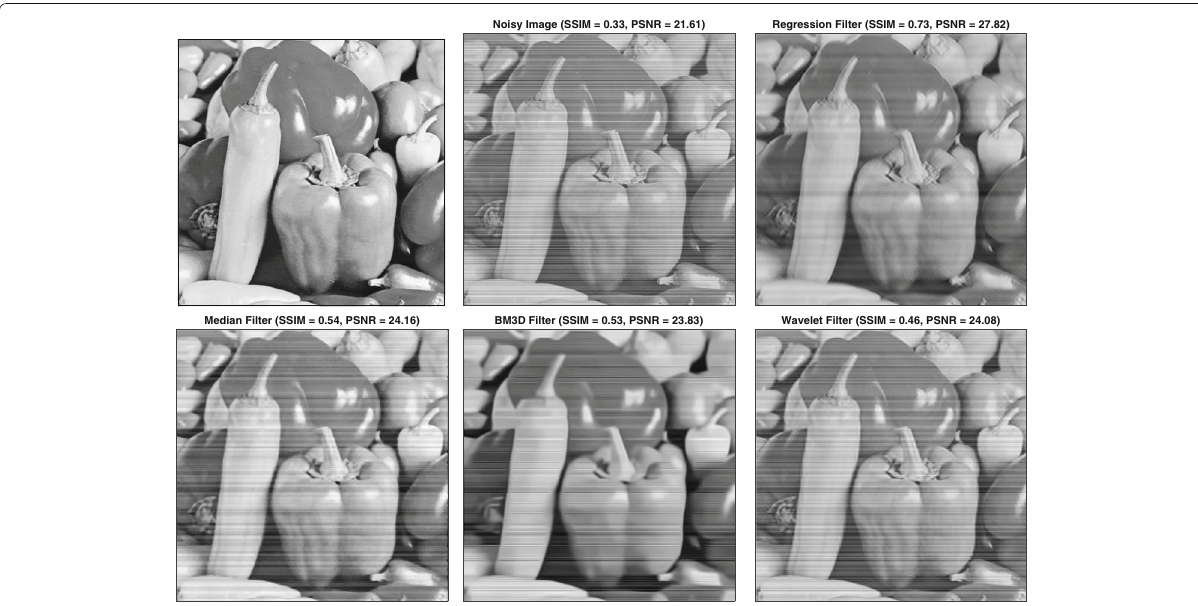
Fig. 5 Added 20% stripped noise. From left to right: a clean peppers, b noisy image, c denoised image using our L 2 regression filter, d denoised image using median filter, e denoised image using BM3D, and f denoised image using wavelet filter